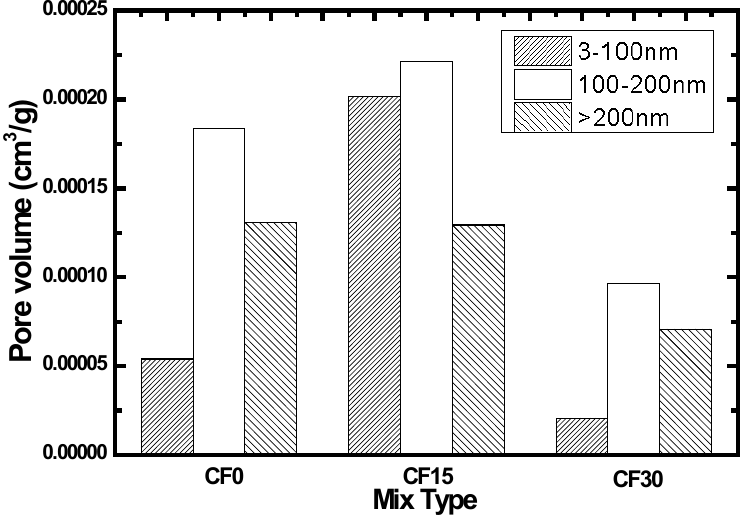
Figure 5. Pore size distribution of concrete sample immersed in ultrapure water at 90 days.